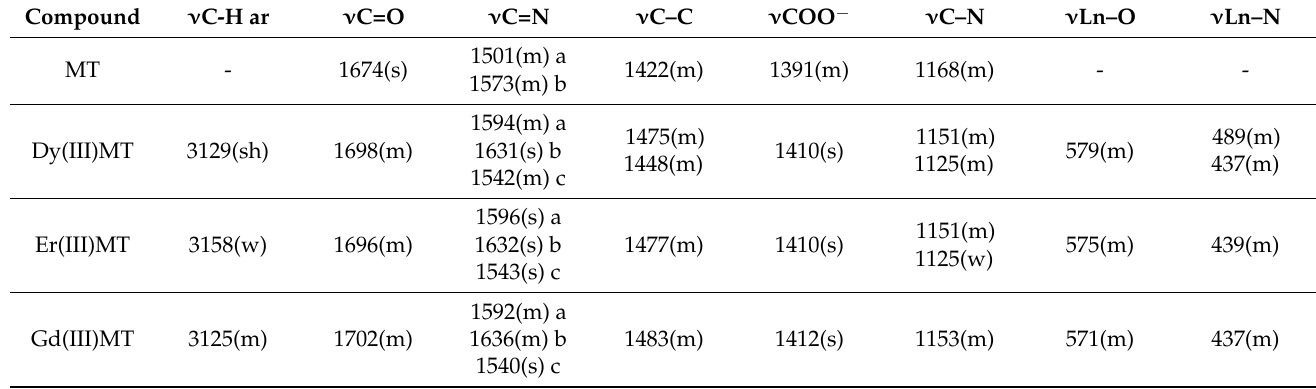
Table 3. IR band assignments (cm − 1 ) for 2,4,6-tris(4-carboxybenzimino)-1,3,5-triazine (MT) and its Ln(III) metal complexes.